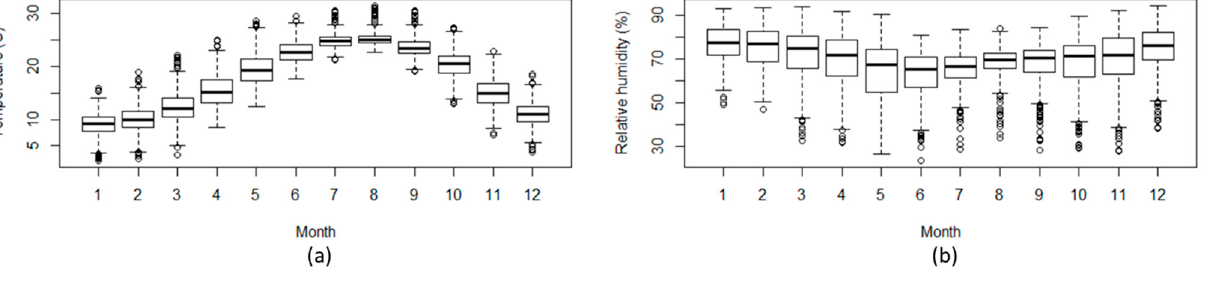
Figure 9. Median, standard deviation, 95% confidence interval, and outliers of monthly values of ( a ) temperature (C), ( b ) relative humidity (%), ( c ) wind speed (m/s), and ( d ) total daily precipitation (mm) in Lebanon for the period 2001–2020. Figure 10. Median, standard deviation, 95% confidence interval, and outliers of yearly values of FWI in Lebanon for the period 2001–2020. 4. Discussion 4.1. Data Quality Assessment Our bibliographical review did not find any homogeneous, classified or organized national records on wildfires in Lebanon, as previously reported [18,78,79], thus motivat- ing our full reconstruction from a standardized method. Previous studies mostly de- scribed the extent and numbers of wildfires based on coarse resolution MODIS global fire products, or inconsistent information provided by different national authorities (such as the ministry of Agriculture, the Ministry of Environment, Civil Defense, etc.) [23,24,78,79]. Our results present the advantage of generating a BA database derived from an objective